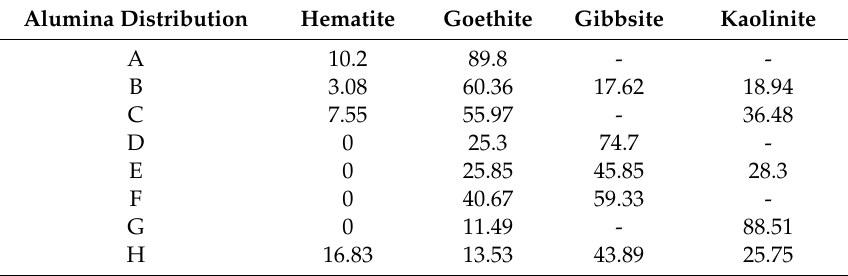
Table 2. Alumina distributions in iron ores